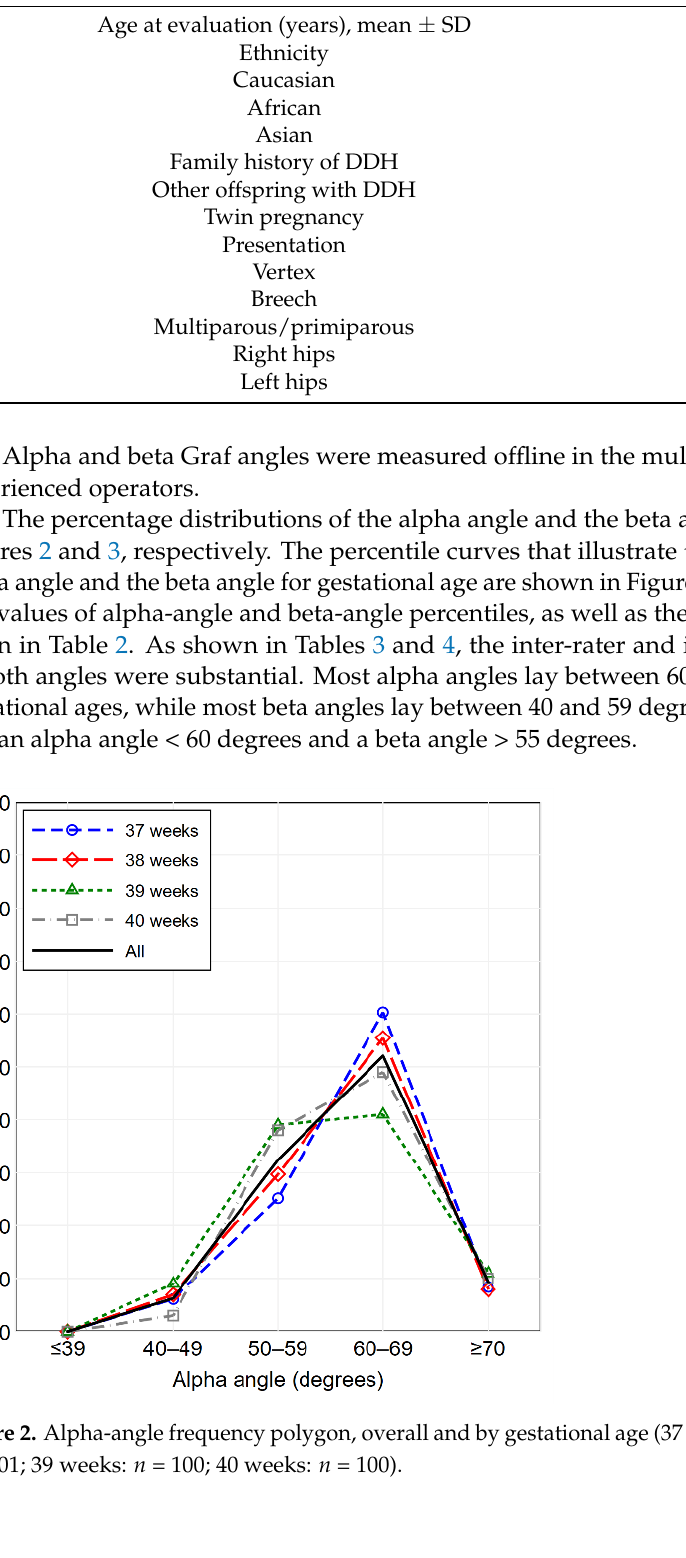
Figure 3. Beta-angle frequency polygon, overall and by gestational age (37 weeks: n = 131; 38 weeks: n = 101; 39 weeks: n = 100; 40 weeks: n = 100).